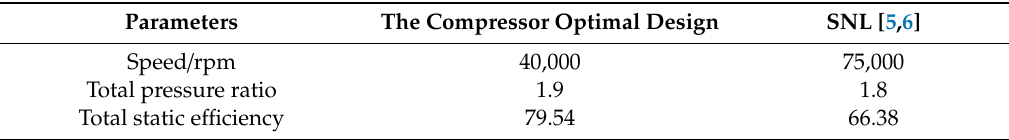
Table 6. Comparison of compressor